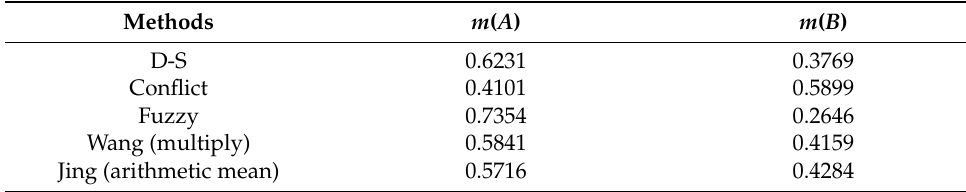
Table 2. Fusion results of different